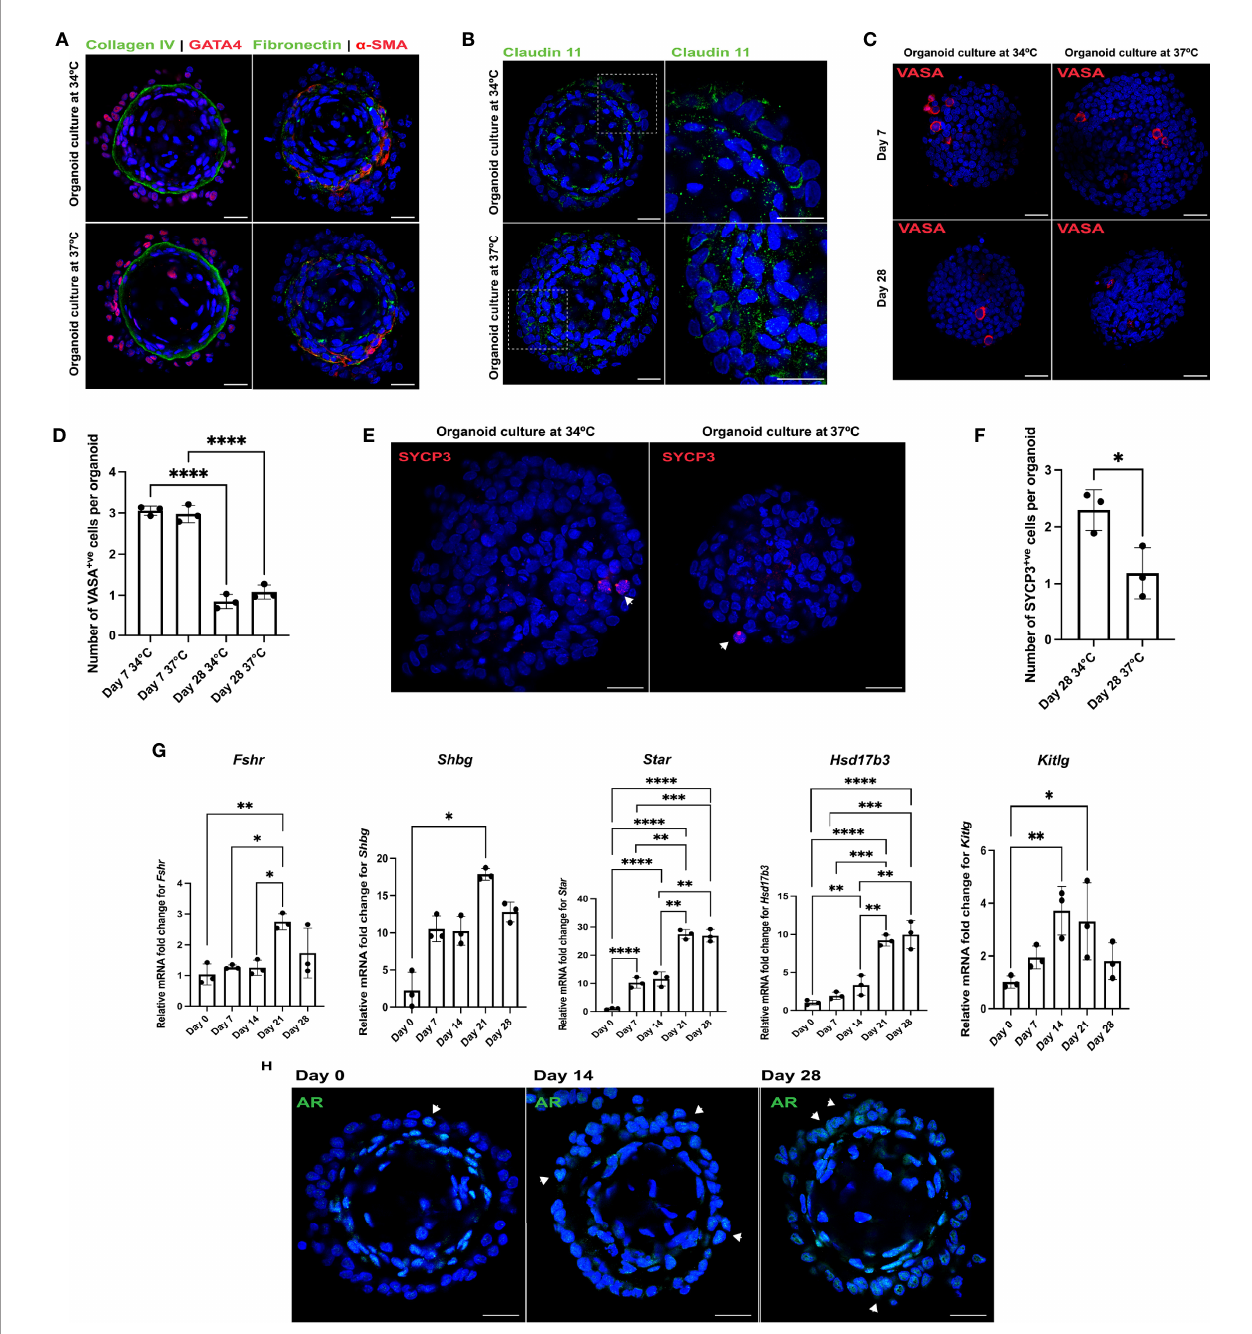
FIGURE 2 | Rat testicular organoids support somatic cell maturation and spermatogonial differentiation at 34°C culture. (A – C, E) Immuno fl uorescent images of day 28 rat testicular organoids cultured at 34°C and 37°C showing (A) basement membrane (collagen IV, fi bronectin), Sertoli cells (GATA4), peritubular myoid cells ( a - SMA), (B) tight junction protein (Claudin 11) (inserts showing the magni fi ed area on the right panel), (C) germ cells (VASA) and (E) meiotic cells (SYCP3) (indicated with white arrows). Scale bars measure 25 m m. (D) Number of germ cells adhered to each organoid. Bars indicate mean ± SD, n = 3. Analysis was performed using one-way ANOVA followed by Tukey ’ s multiple comparison test. (F) Number of meiotic cells adhered to each organoid. Bars indicate mean ± SD, n = 3. Analysis was performed using unpaired two-tailed t -test. (G) Relative mRNA fold change of Fshr , Shbg , Star , Hsd17b3 and Kitlg for organoids cultured at 34°C. Bars indicate mean ± SD, n = 3. Analysis for Fshr , Star , Hsd17b3 and Kitlg was performed using one-way ANOVA followed by Tukey ’ s multiple comparison test and analysis for Shbg was performed using Kruskal-Wallis test with Dunn ’ s multiple comparison test. (H) Immuno fl uorescent detection of AR (indicated with white arrows) in the 34°C culture at day 0, day 14 and day 28. Scale bars measure 25 m m. p ≤ 0.05 (*), p ≤ 0.01 (**), p ≤ 0.001 (***), p ≤ 0.0001 (****). Only signi fi cant differences are indicated with